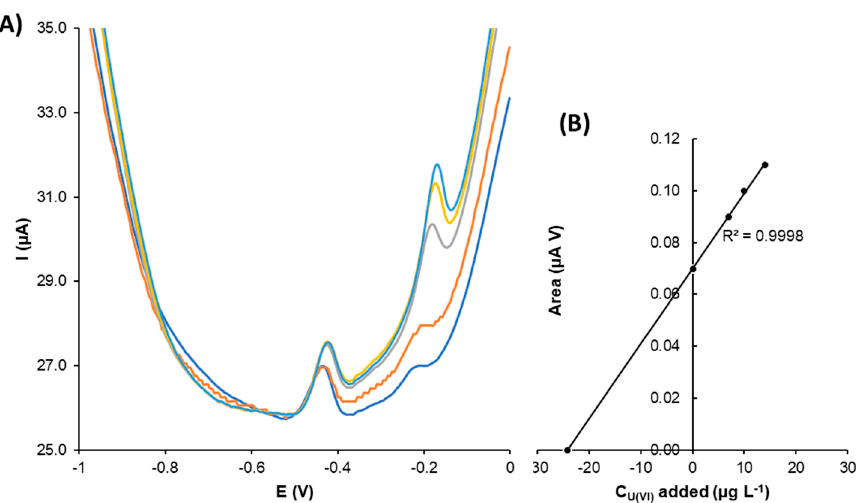
Figure 9. ( A ) DPASV voltammograms obtained for uranyl ion in spiked tap water using G-AgNPs- SPCNFE in acetic acid/acetate buffer 0.1 M pH 4.5 with an E d of − 1.2 V and a t d of 300 s, and ( B ) uranyl standard addition curve.